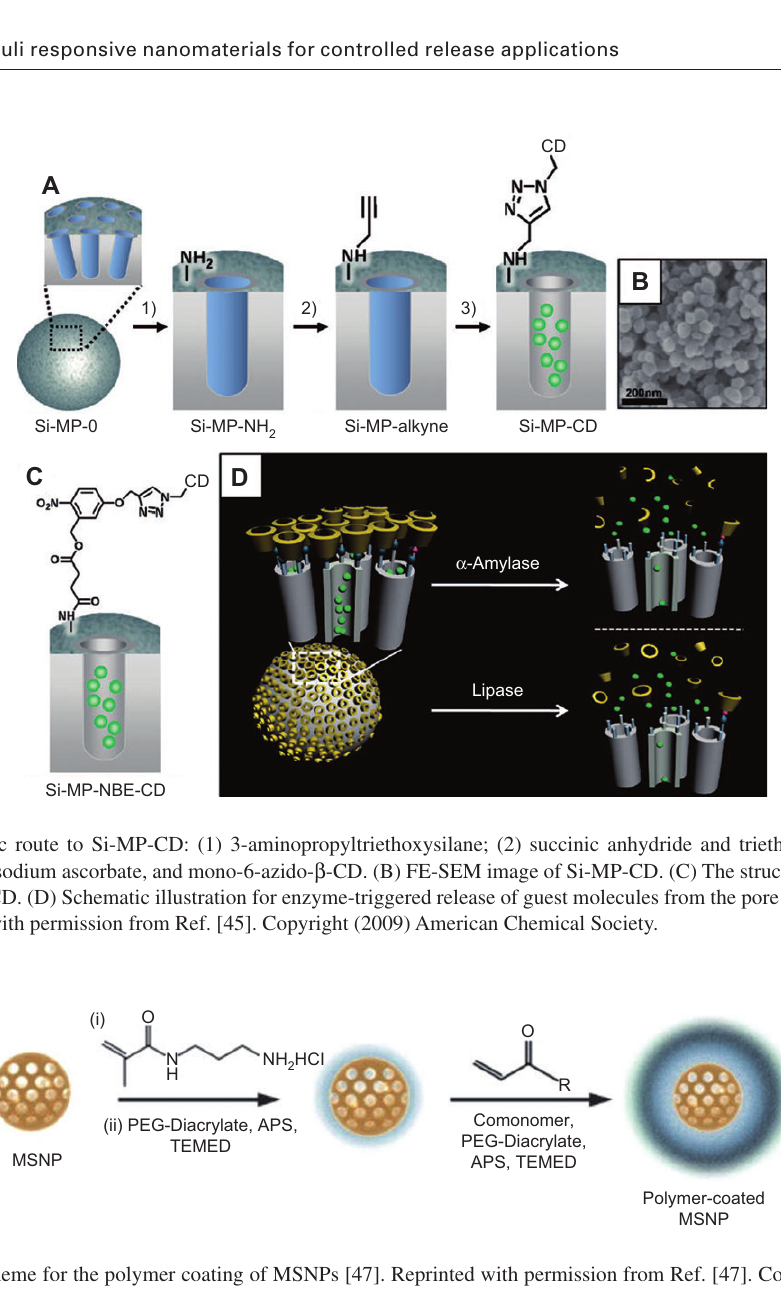
Figure 8 Synthetic scheme for the polymer coating of MSNPs [47] . Reprinted with permission from Ref. [47] . Copyright (2011) American Chemical Society.